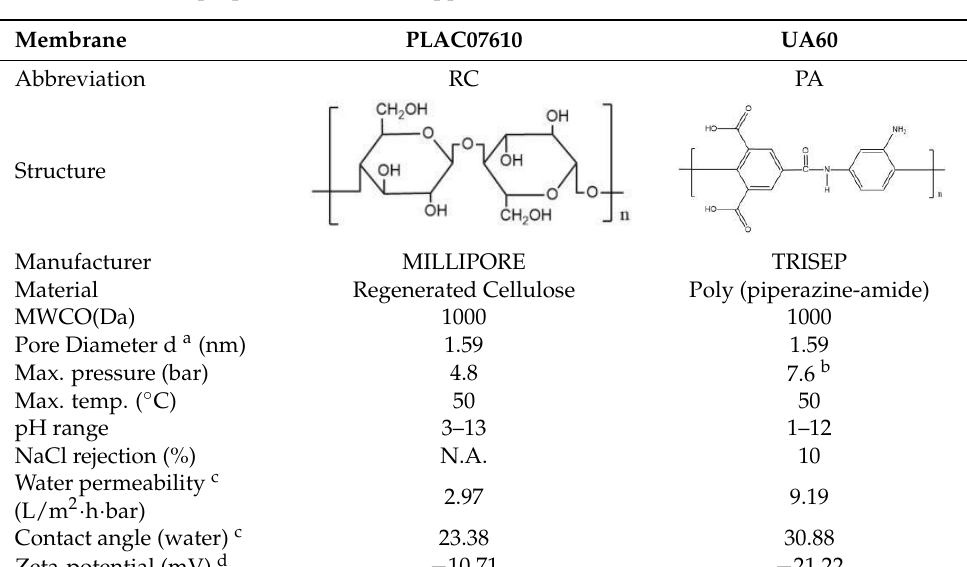
Table 2. Membrane properties (N.A. = not applicable).